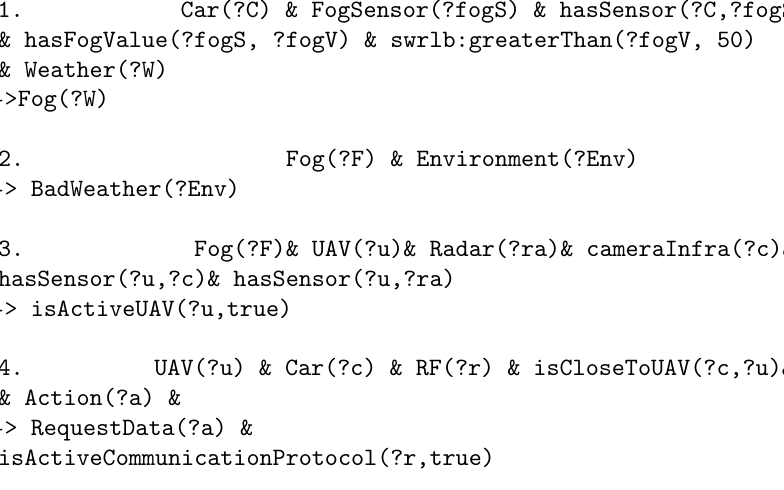
Figure 8. Set of rules for the management of a foggy